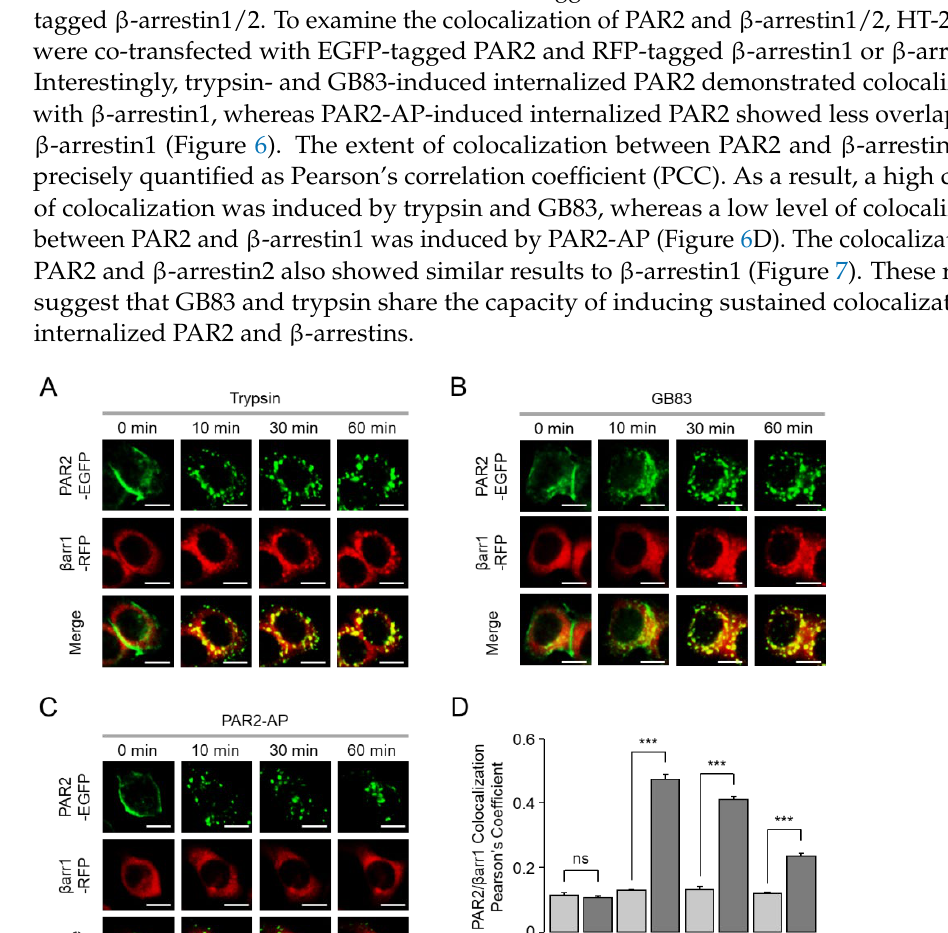
Figure 7. GB83 induces sustained colocalization of PAR2 and β -arrestin2. ( A – C ) Effect of trypsin, GB83, and PAR2-AP on the localization of PAR2 and β -arrestin2 (βarr2) in HT-29 cells expressing EGFP-tagged PAR2 and RFP-tagged β -arrestin2. Cells were treated with trypsin (30 U/mL), GB83 (30 µM), PAR2-AP (30 µM), and the cellular localization of PAR2 (green) and β -arrestin2 (red) were observed at 0, 10, 30, and 60 min after treatment of each agonist. ( D ) Quantitative analysis of